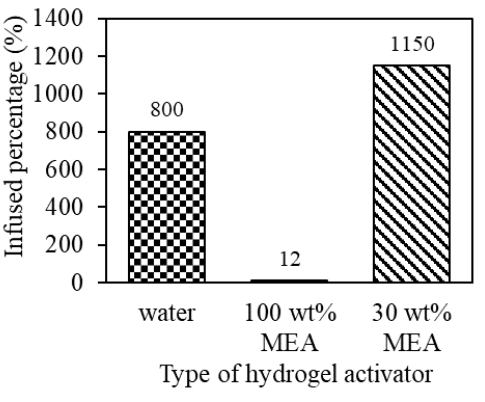
Figure 7. Water, 100 wt% MEA and 30 wt% MEA infused percentage in 0.5FA-AAc/AAm hydrogel. As shown in Figure 8a,b, at temperature of 30 °C, pressure of 2 bar and flowrate of 60 mL/min, the CO 2 adsorption capacity of water infused 0.5FA-AAc/AAm hydrogel was